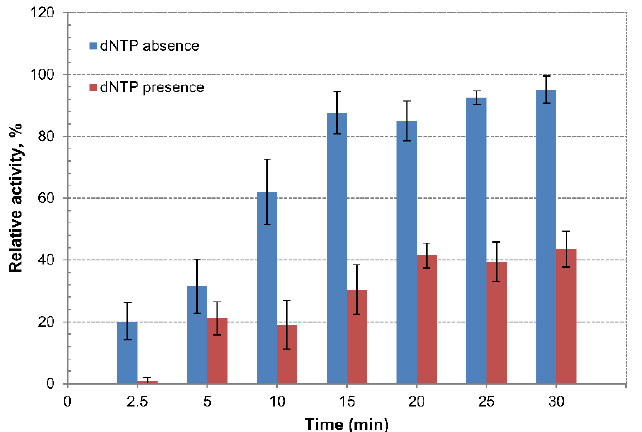
Figure 5. Examination of 3′ - 5′ exonuclease activity of Tt72 pol. The activity was measured in the absence and presence of dNTPs (100 µM) in the reaction mixture. The reaction was carried out at 55 °C. Values represent the mean ± standard deviation ( n = 3).